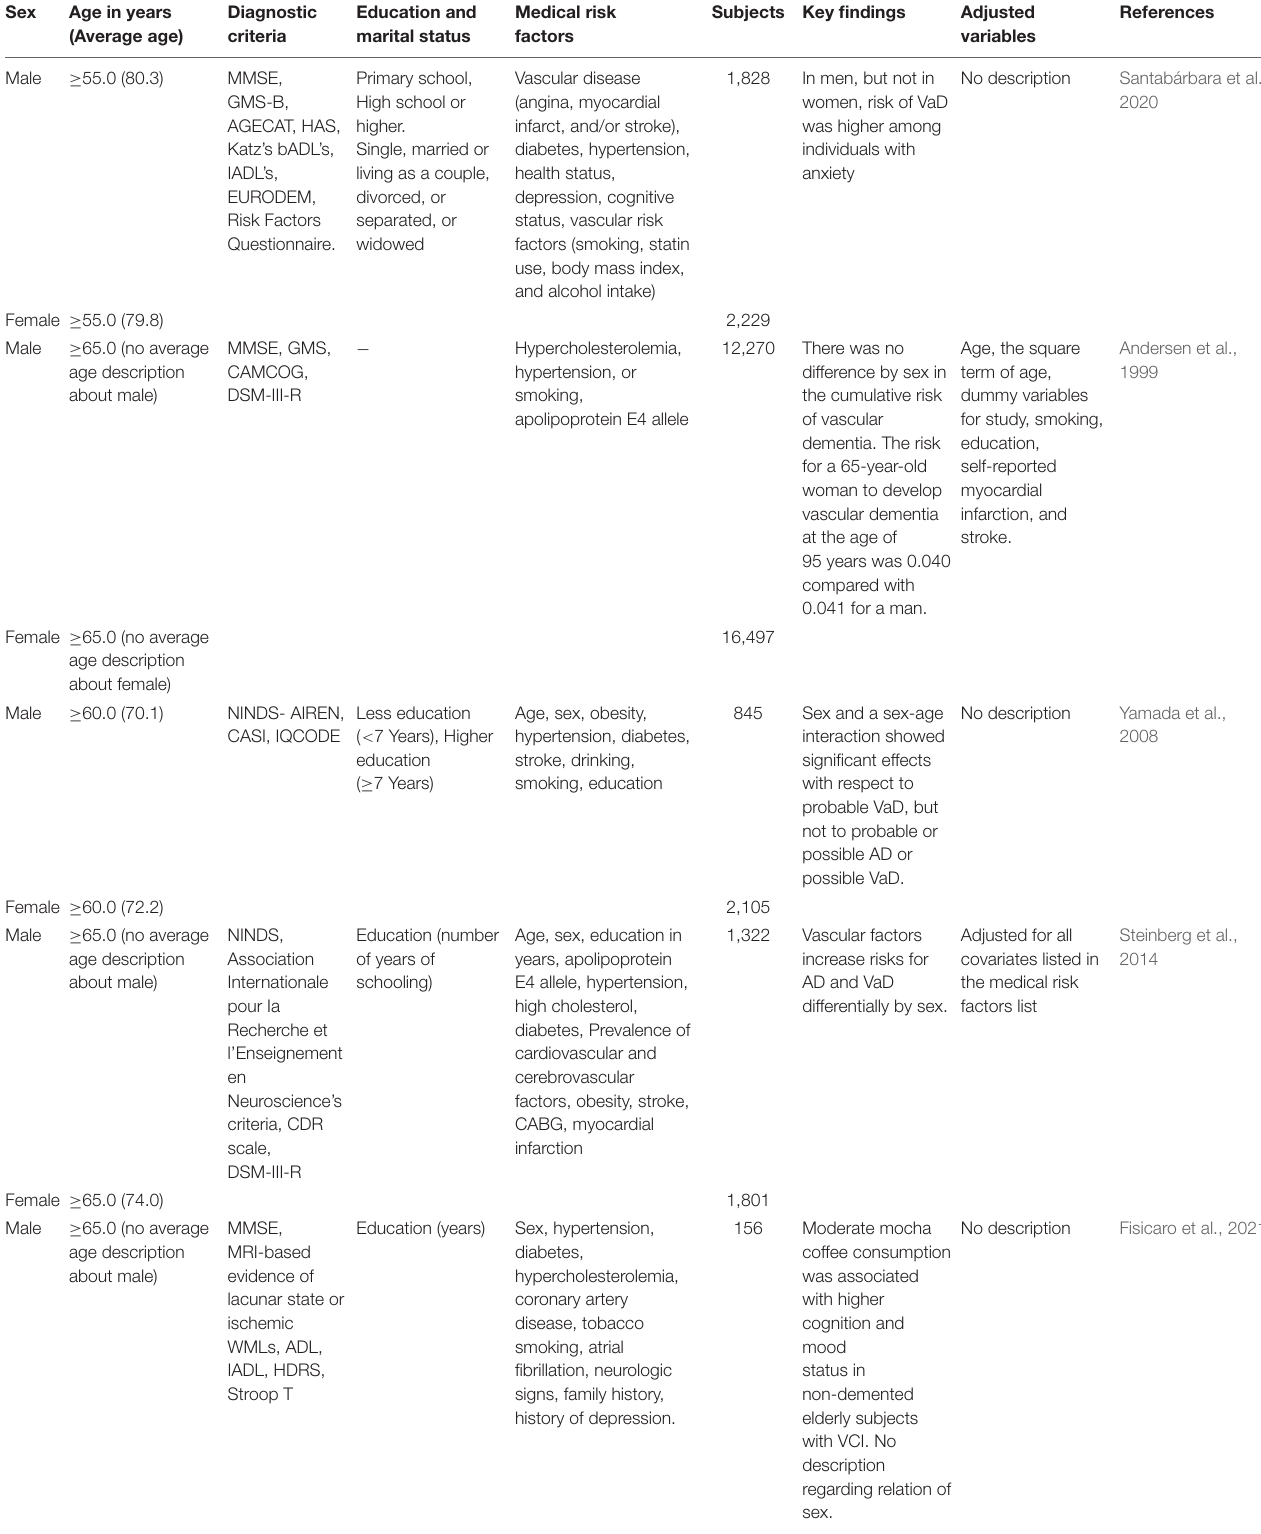
TABLE 1 | Studies on vascular dementia (VaD) in relation with sex or